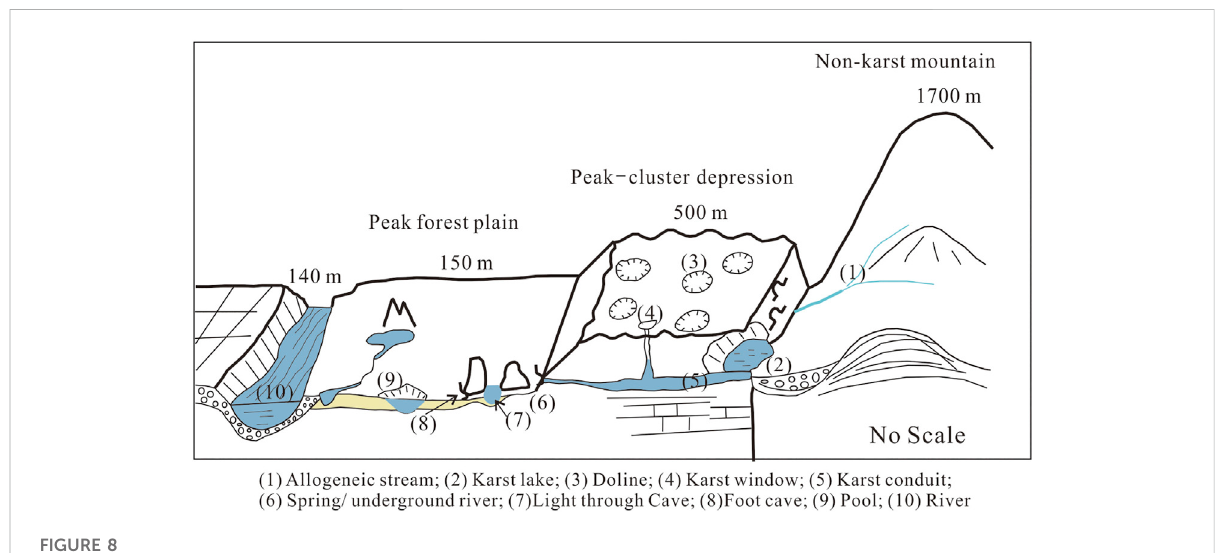
FIGURE 8 The sketch map of karst wetlands and their relationship between rivers in Lijiang River watershed.